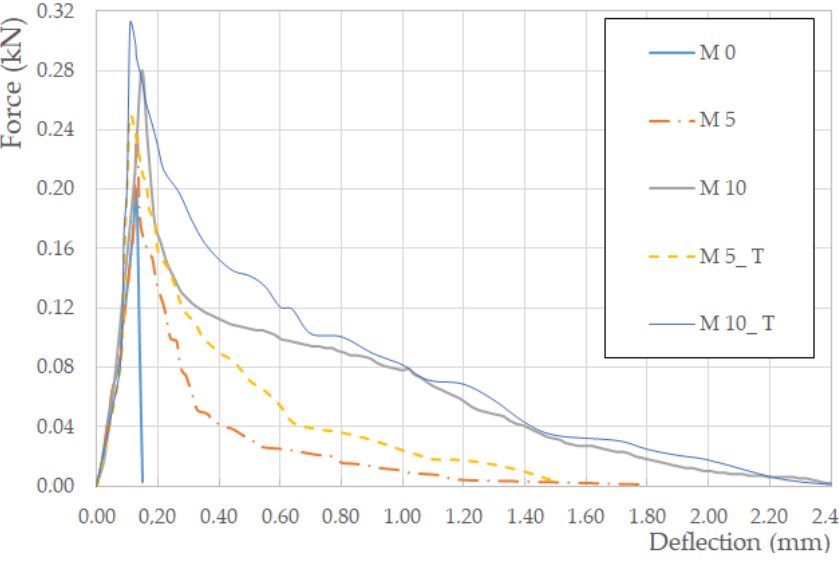
Figure 7. Load deflection plot for M materials.